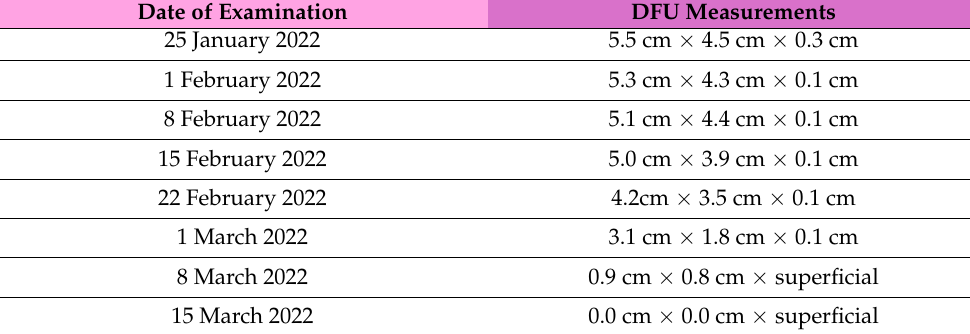
Figure 1. Progression of the diabetic foot ulcer throughout amniotic membrane allograft applications. ( A ) Date of exam: 1 February 2022; DFU measurements: 5.3 cm × 4.3 cm × 0.1 cm. ( B ) Date of exam: 22 February 2022; DFU measurements: 4.2 cm × 3.5 cm × 0.1 cm. ( C ) Date of exam: 15 March 2022; DFU measurements: DFU is now closed. Table 1. Measurements of the DFU at each time point.